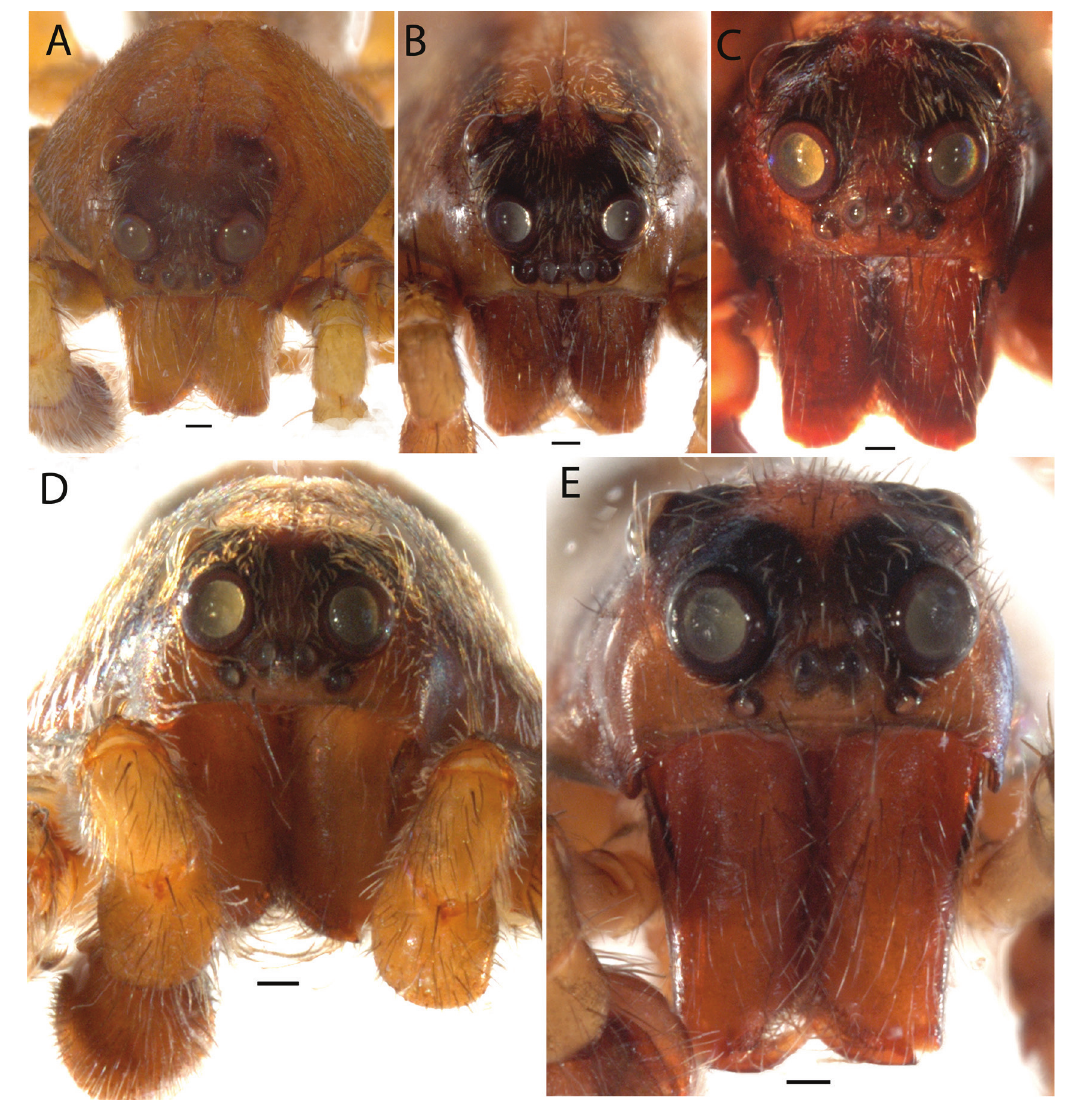
Figure 2. Artoria males, anterior eye row, frontal view: A , A. strepera sp. n. (AM KS127760) straight, evenly spaced; B , A. bar- ringtonensis sp. n. (AM KS122794) straight, distance between AME/AME at least twice of AME/ALE.; C , A. kanangra (KS45008) slightly procurved, evenly spaced; D , A. belfordensis sp. n. (AM KS127759) eyes strongly procurved, evenly spaced.; E , A. extraor- dinaria sp. n. (AM KS128074) eyes strongly procurved, distance between AME/ALE at least twice AME/AME. Scale bars: 0.1